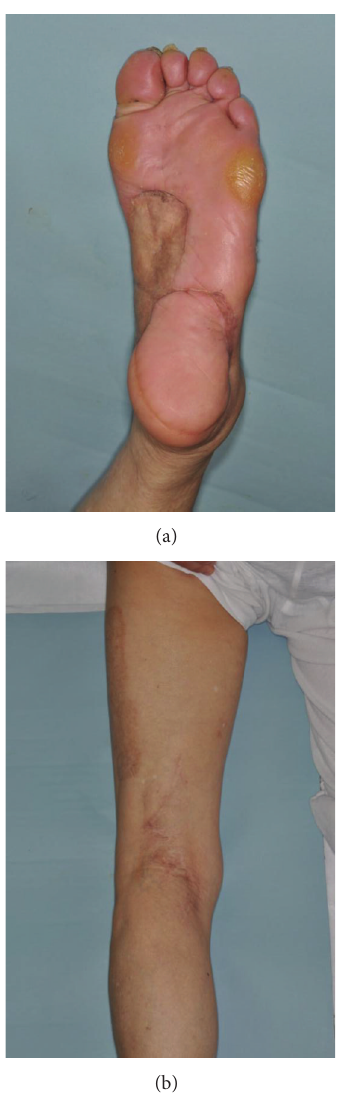
Figure4:The33-monthpostoperativefindingsofthepatient’slower extremity. There were no local or systemic signs of recurrence, and lymphedema was not seen in the left lower